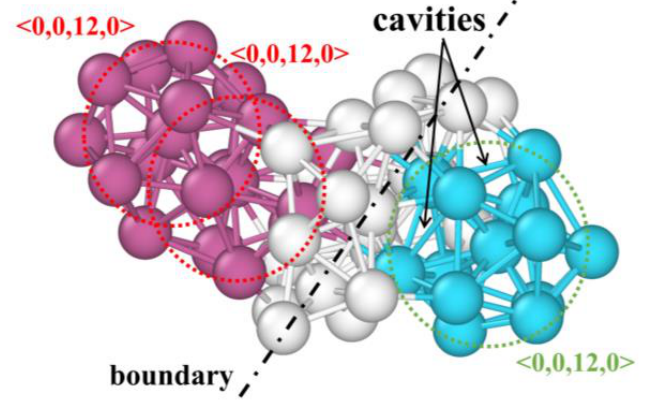
Figure 8. Local atomic structure of MRO defects.